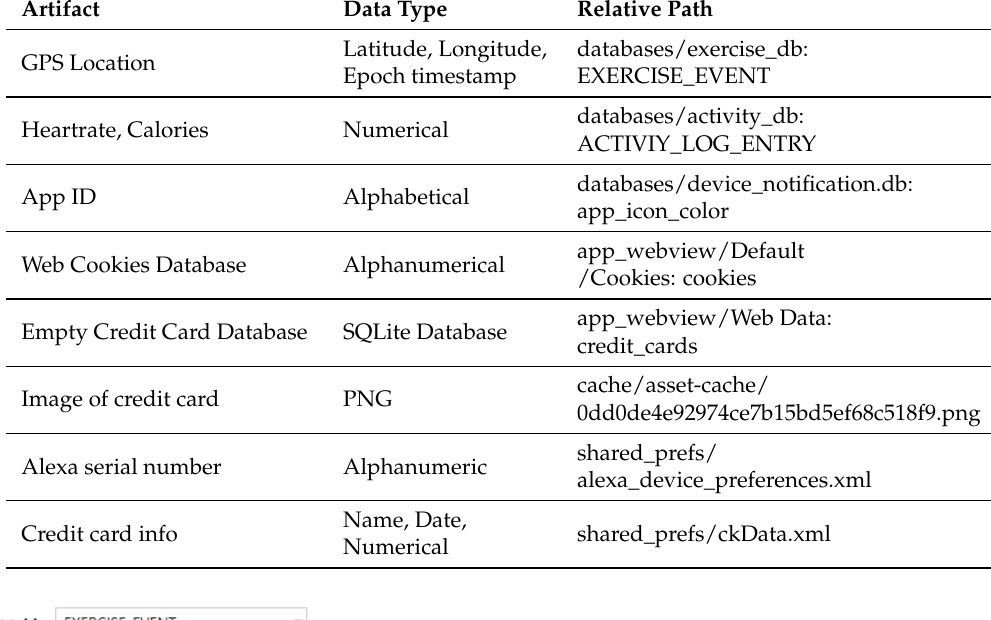
Table 2. Artifacts found at respective locations in Fitbit application under /data directory.